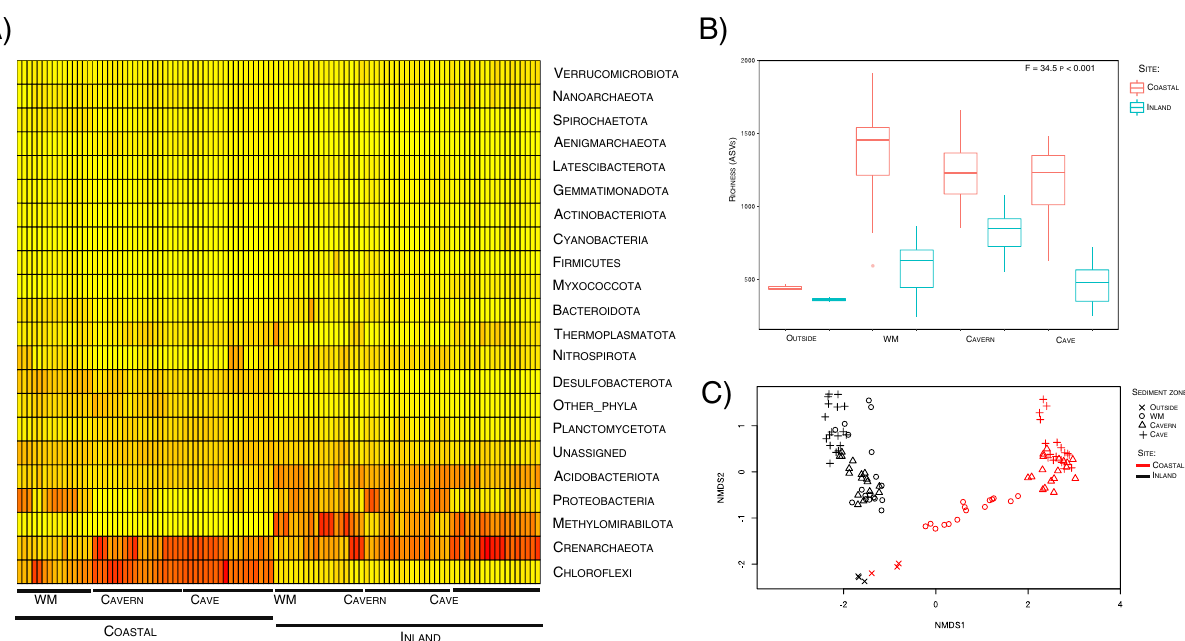
Figure 2. Differences in the sediment microbial communities from the coastal and inland sinkholes (data group 1). ( A ) Heat map of the 20 most abundant phyla. Columns represent sediment samples, rows depict phyla. Low abundance (yellow), high abundance (red). ( B ) Richness of ASVs within the sites and sediment zones from sinkholes. ( C ) Beta diversity analysis of the sediment samples. Non-metric multidimensional scaling (nMDS) plot based on the Bray–Curtis distance of 9402 ASVs (Figures created with